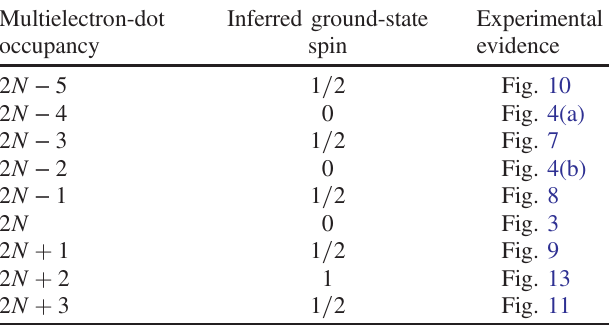
TABLE I. Summary of the inferred ground-state spin for 9 subsequent charge occupancies of the multielectron quantum dot. A sequence of alternating spin-0 and spin- 1 = 2 states is inter- rupted once by a spin-1 ground state. To emphasize the role of electron parity, we have arbitrarily chosen one even dot occu- pation as a reference, labeled 2 N , and specify other dot occupations relative to that occupation.